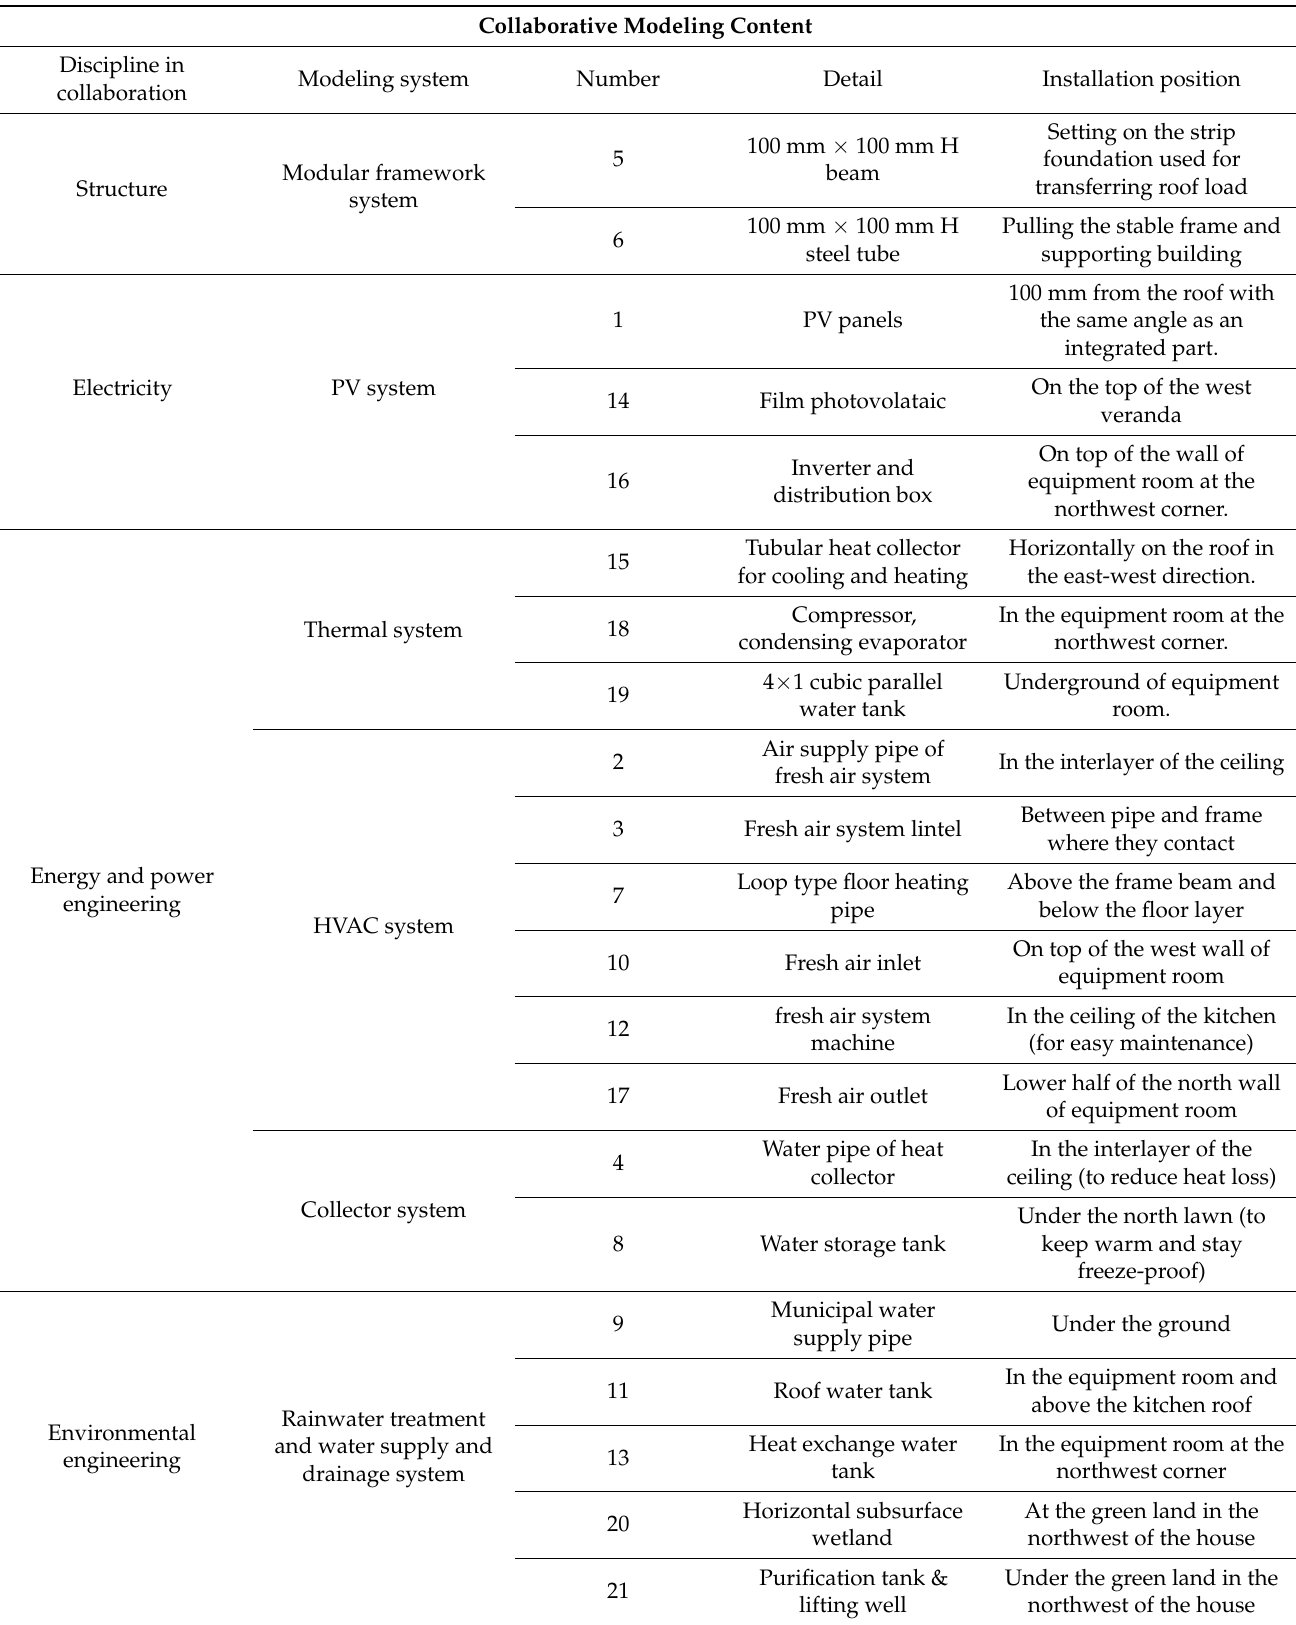
Table 7. Collaborative modeling contents across